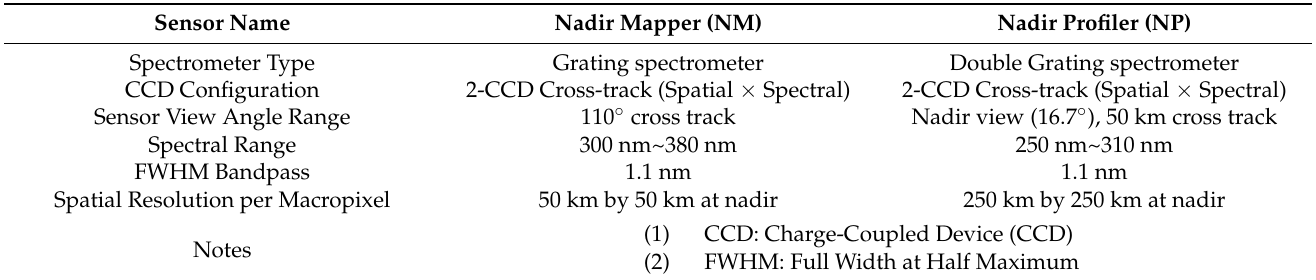
Table 1. SNPP OMPS NM and NP Instrument